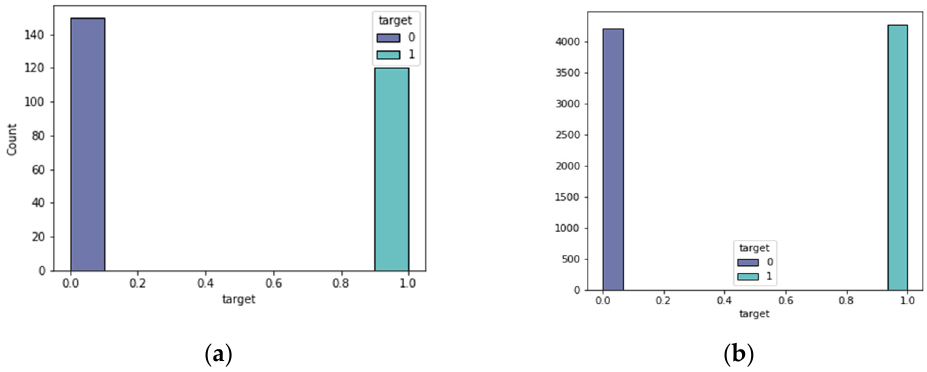
Figure 3. Heart disease classes. ( a ) the Statlog dataset; ( b ) the cardiovascular dataset. Table 2. Number of selected features for each heart disease dataset using the SVM